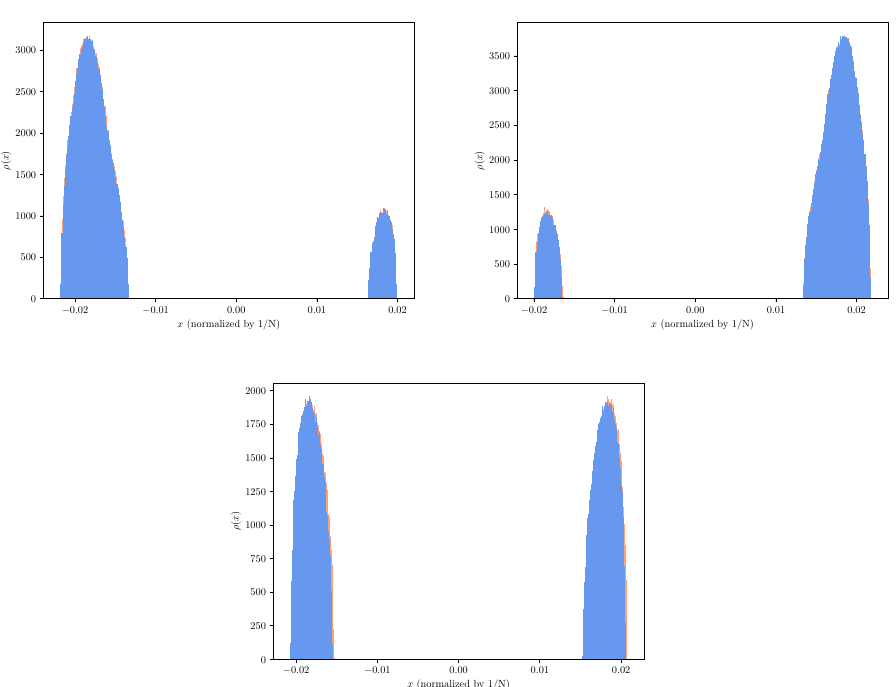
Figure 11: The eigenvalue distribution of two matrices for g = 1 / 30 and h = 1 / 15 with N = 300 for the potential given in (43) and shown in Fig. 10. These correspond to green (top left), magenta (top right), red (bottom) data points respectively of Fig. 10. Note that blue and orange distribution overlaps and means that we have X → Y symmetry as expected.